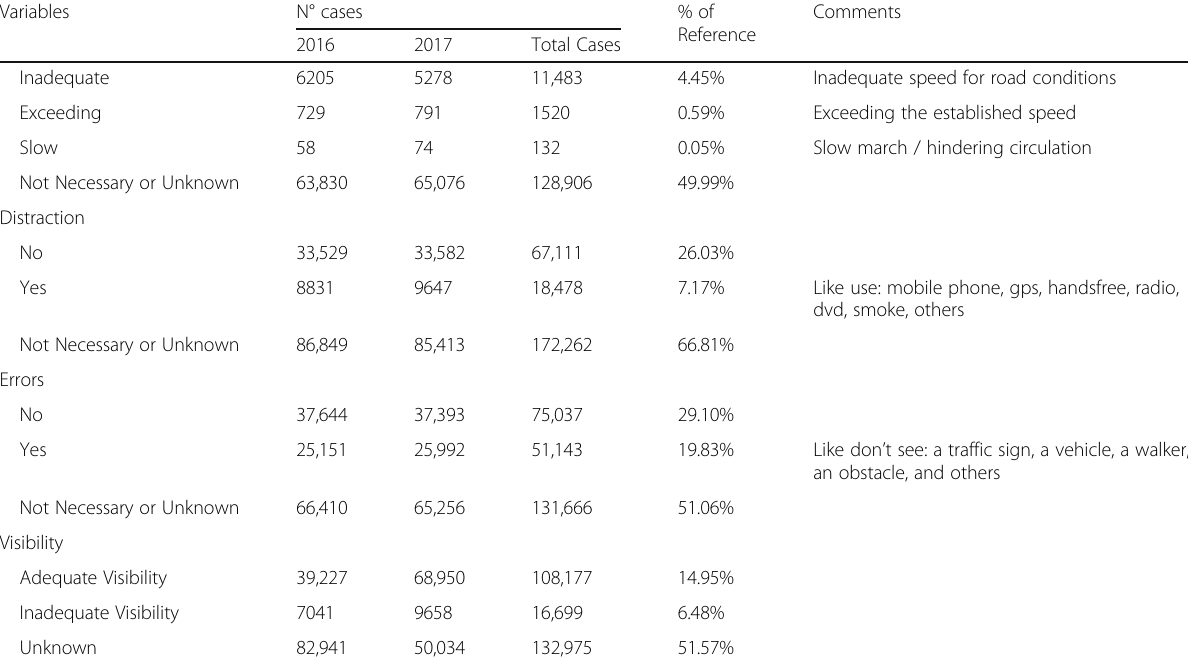
Table 1 Total number of cases analyzed. Processed by the Authors (Continued) Variables N° cases